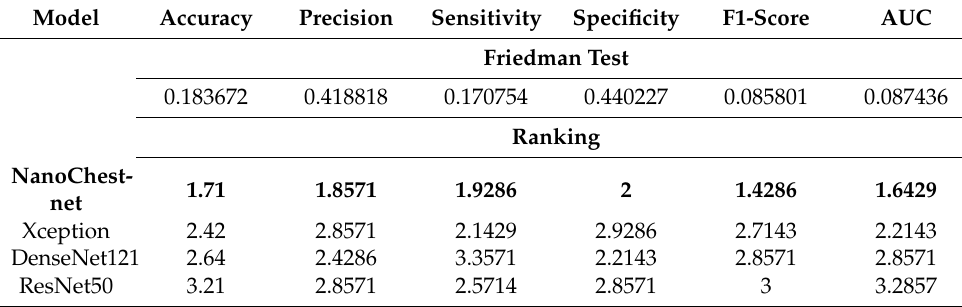
Table 11. Friedman test over each metric for all models.